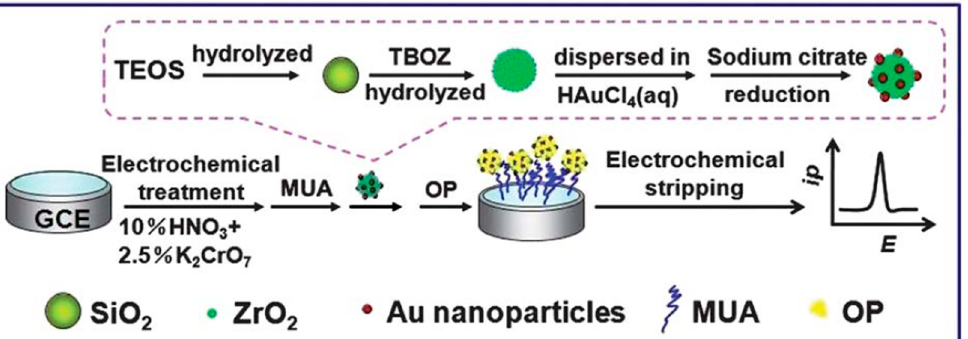
Figure 6. Schematic presentation of the development of the electrochemical sensor for detection of paraoxon-ethyl pesticide, which proceeds via paraoxon-ethyl adsorption and electrochemical strip- ping detection of the adsorbed pesticide. The scheme includes individual synthesis steps to prepare the Au-ZrO 2 -SiO 2 nanocomposite, used as a modifier of the GCE. TEOS—tetraethoxysilane, TBOZ— zirconium n-butoxide, MUA—11-mercaptoundecanoic acid, OP—organophosphorous pesticides. Reprinted with permission from Ref. [76] . Copyright 2012 The Royal Society of Chemistry.